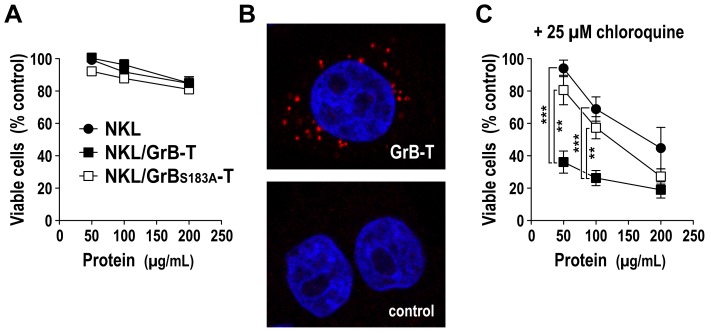
Cytotoxic activity of proteins released by activated NK cells.(A) EGFR-positive MDA-MB468 cells were treated with increasing concentrations of total proteins from supernatants of activated NKL (closed circles), NKL/GrB-T (closed squares), or NKL/GrBS183A-T cells (open squares). After 24 h, the relative number of viable cells in comparison to medium-treated controls was determined in WST-1 assays. Mean values ± SEM are shown; n = 9. (B) To investigate uptake and intracellular localization of GrB-T protein, MDA-MB468 cells were treated with GrB-T-containing supernatant from NKL/GrB-T cells for 60 min at 4°C, washed and incubated for another 90 min at 37°C, before staining with GrB-specific antibody (red) and confocal laser scanning microscopy. Control cells were incubated with supernatant from activated parental NKL cells. Nuclei were stained with DAPI (blue). Merged images are shown. (C) To facilitate release of internalized proteins from endosomes, MDA-MB468 were treated with total proteins from supernatants of activated NKL, NKL/GrB-T, or NKL/GrBS183A-T cells in the presence of 25 µM of the endosomolytic reagent chloroquine, and the relative number of viable cells in comparison to controls treated with chloroquine-containing medium was determined in WST-1 assays. Mean values ± SEM are shown; n = 9. ***, P<0.001; **, P<0.01.